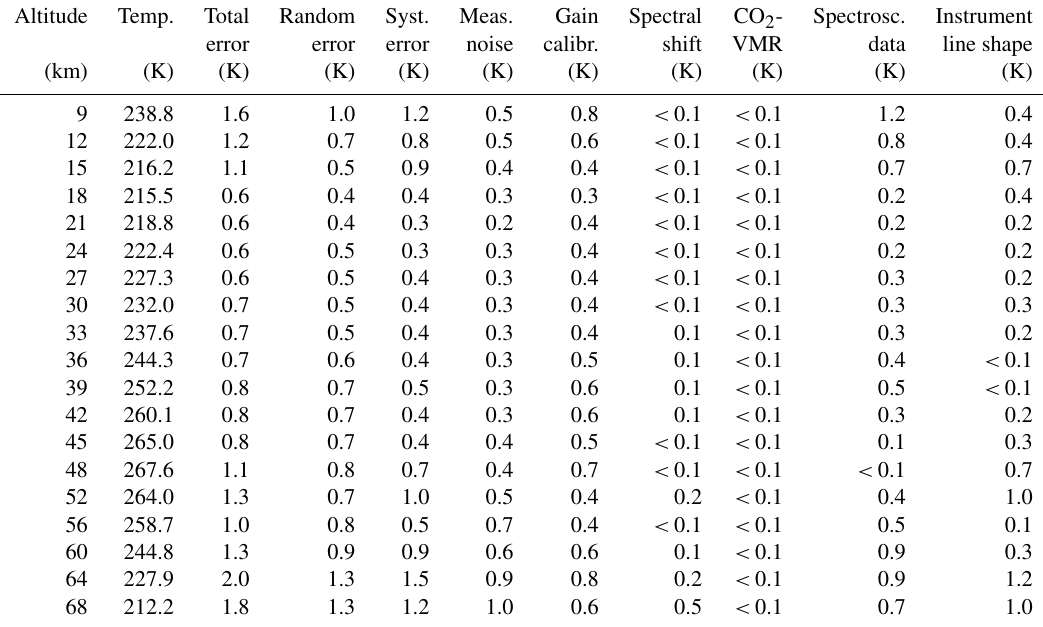
Table A4. FR data temperature error budget for northern midlatitude summer day. All uncertainties are 1 σ . Altitude